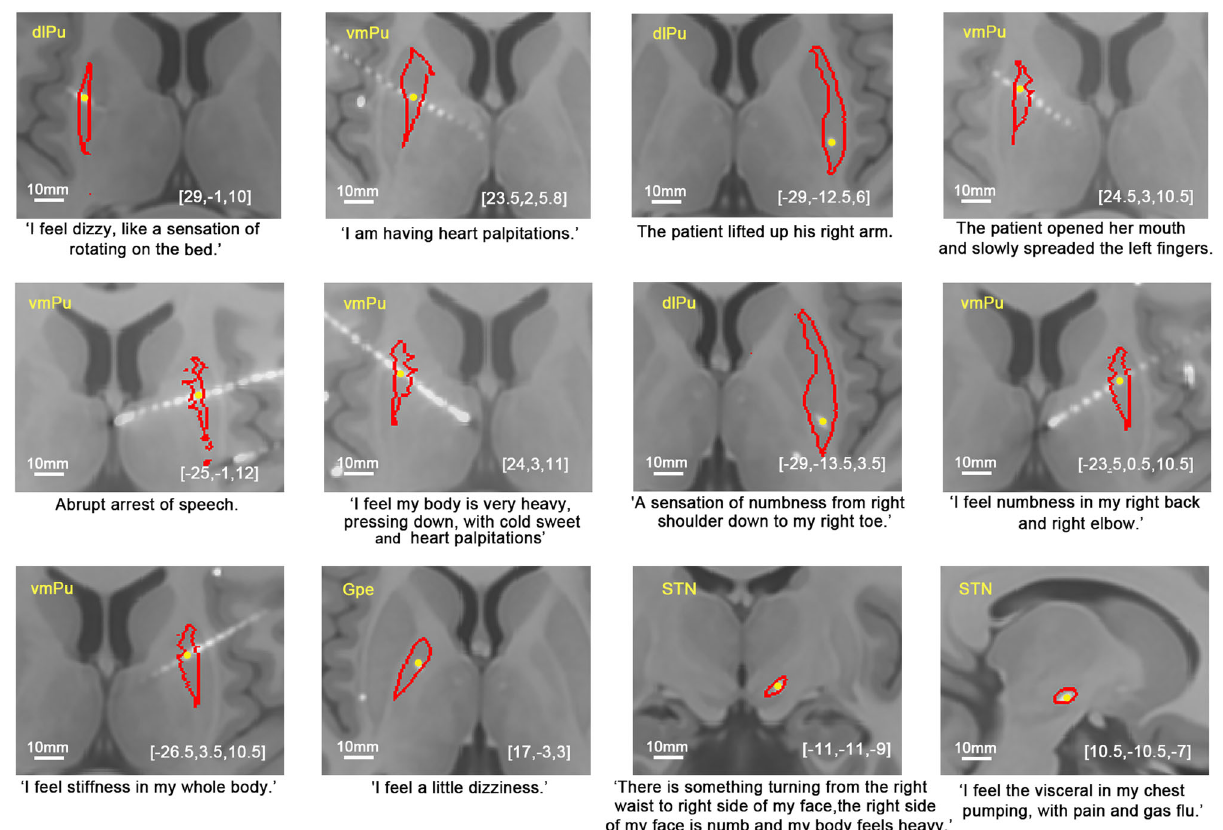
Fig. 2 Examples of the diverse motor and non-motor responses arising from DES of the BG. These panels show examples of individual contact sites in various BG subnuclei (red contour line) in MNI space and detailed reports and/or objective responses from patients during the stimulation of the corresponding sites (yellow dots). The white line of the scale bar indicates 10 mm distance. DES direct electrical stimulation, vmPu ventromedial putamen, dlPu dorsolateral